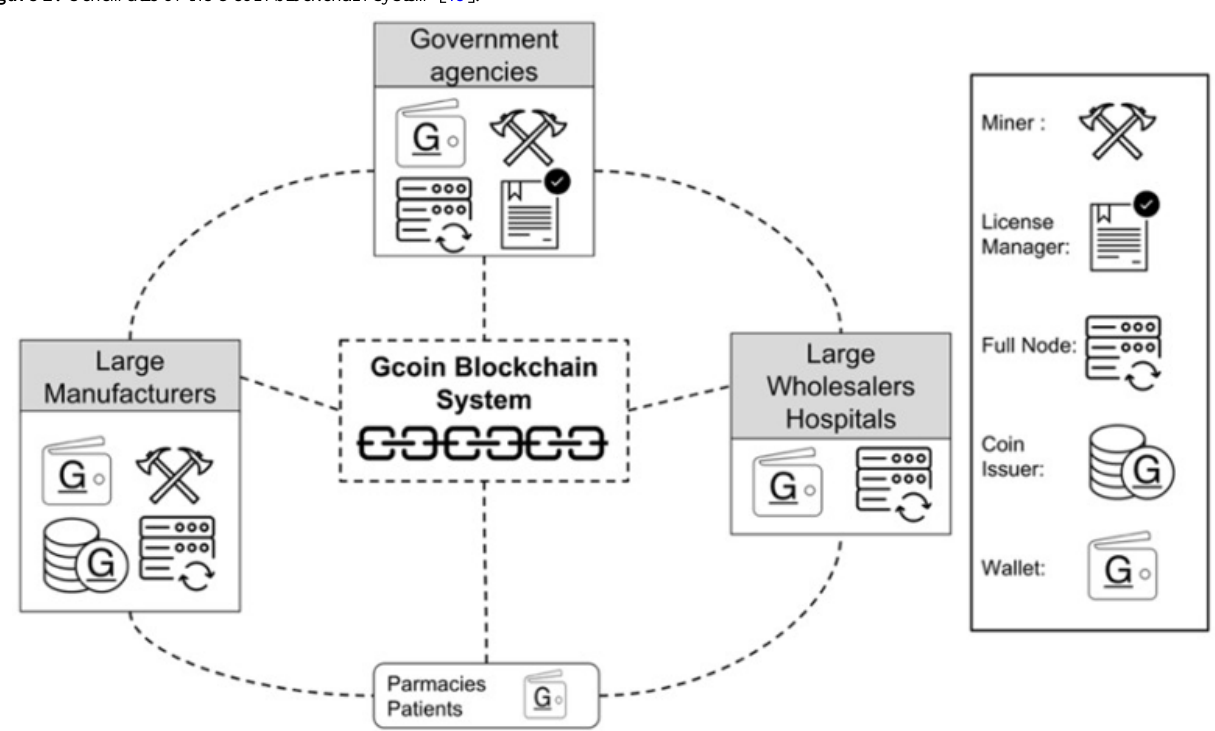
Figure 2. Schematic of the Gcoin blockchain system